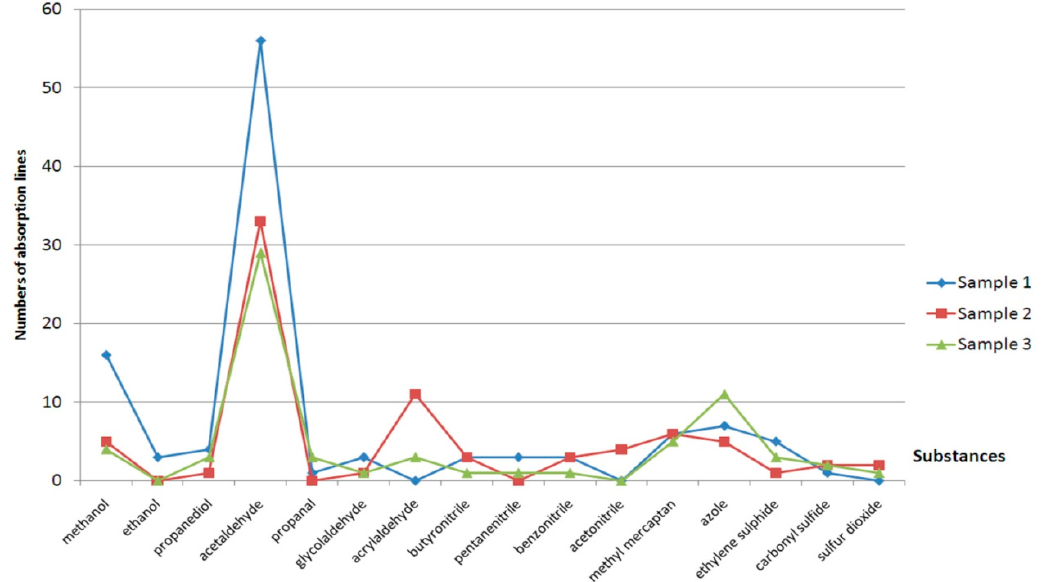
Figure 4. Chemical composition of thermal decomposition products of a relatively healthy nasal mucosa.